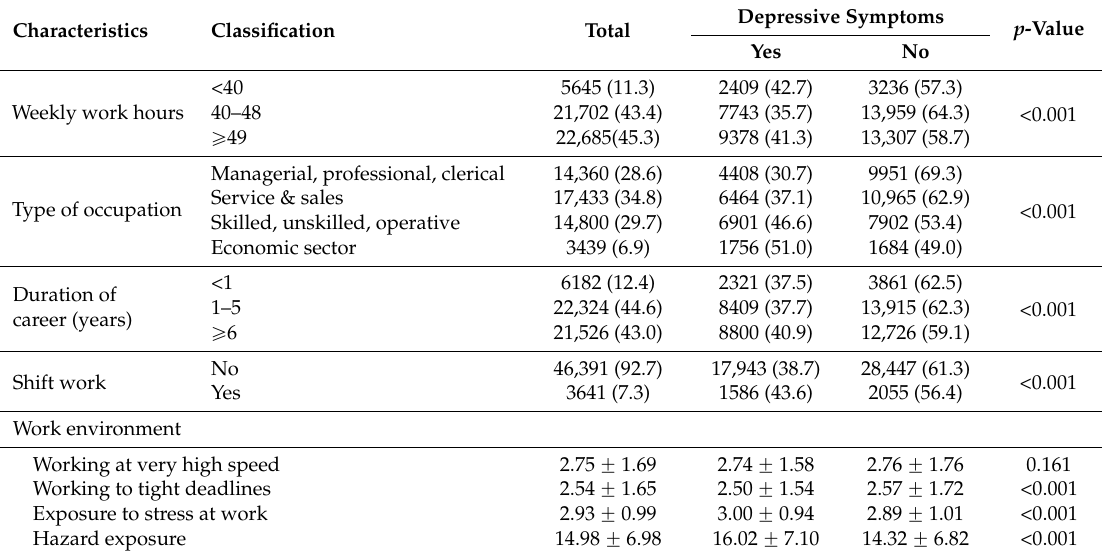
Table 2. Association between depressive symptoms and work-related